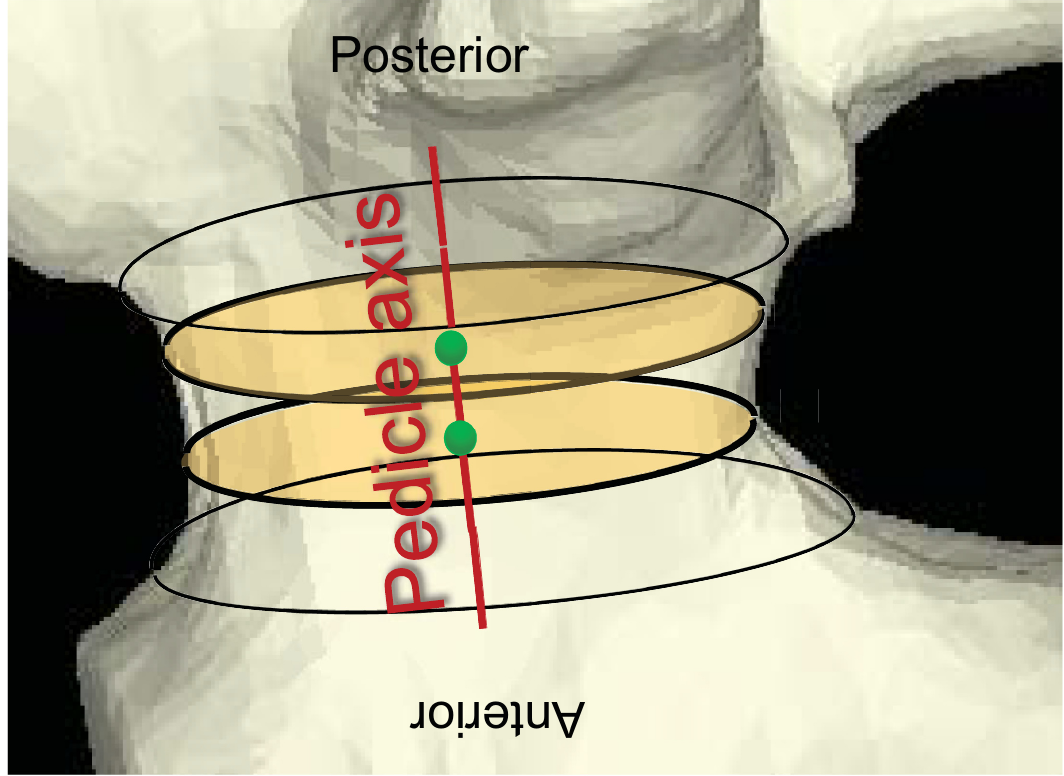
Fig 1. Determination of the pedicle axis at the 3D CT model. The green spheres are centroids at cross sections located at the anterior one-third and the posterior one-third of the pedicle. The yellow ellipses show the cross sections located at the anterior one- third and the posterior one-third of the pedicle. The red line is axis of the pedicle.